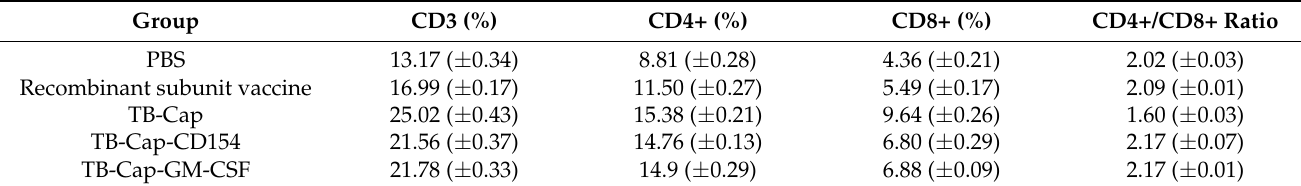
Figure 7. The changes of lymphocyte subsets after immunization were analyzed by flow cytometry.